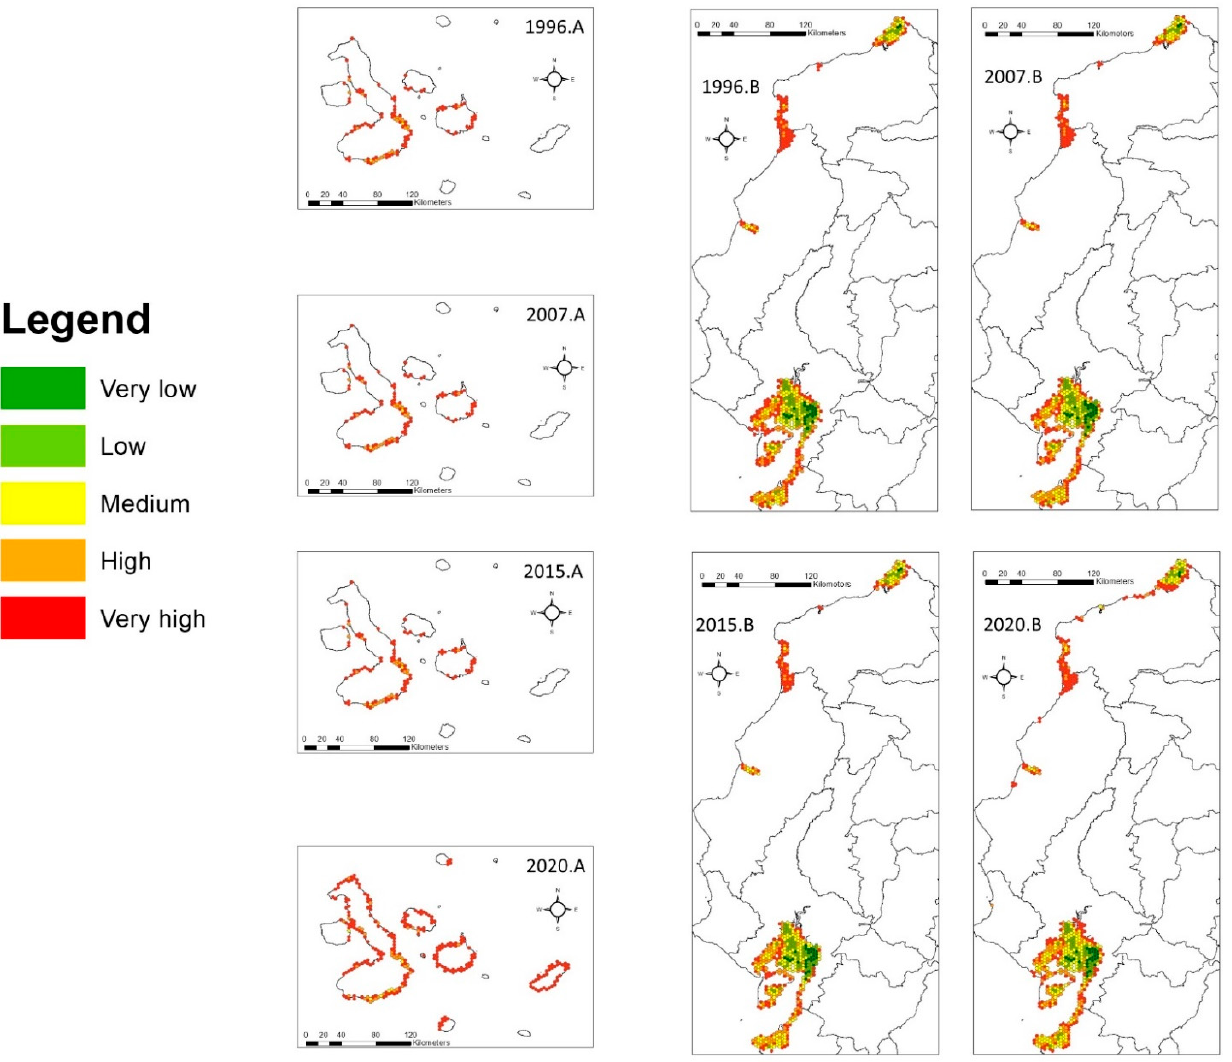
Figure 3. Spatial evolution of RFI in each period. ( A ) Galapagos province. ( B ) Ecuadorian coastal profile.